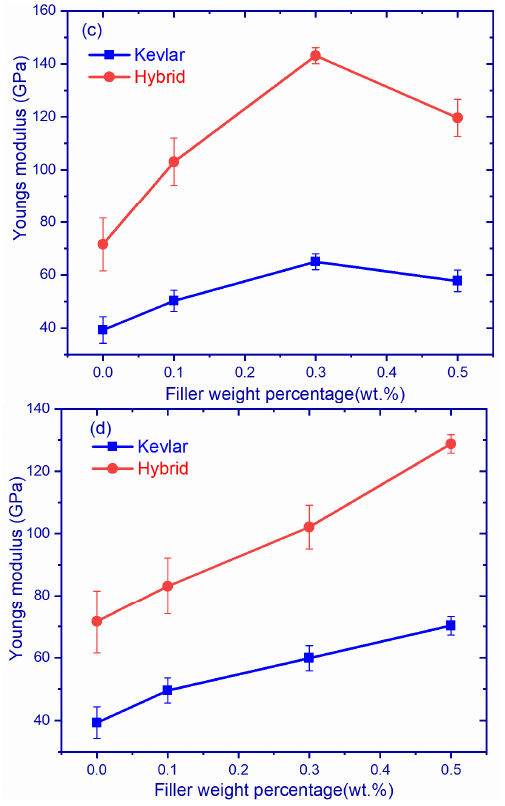
Figure 4. Ultimate tensile strength of ( a ) graphene-reinforced composites, ( b ) hBN-reinforced com- posites, Young’s modulus of ( c ) graphene-reinforced composites, and ( d ) hBN-reinforced compo- sites.